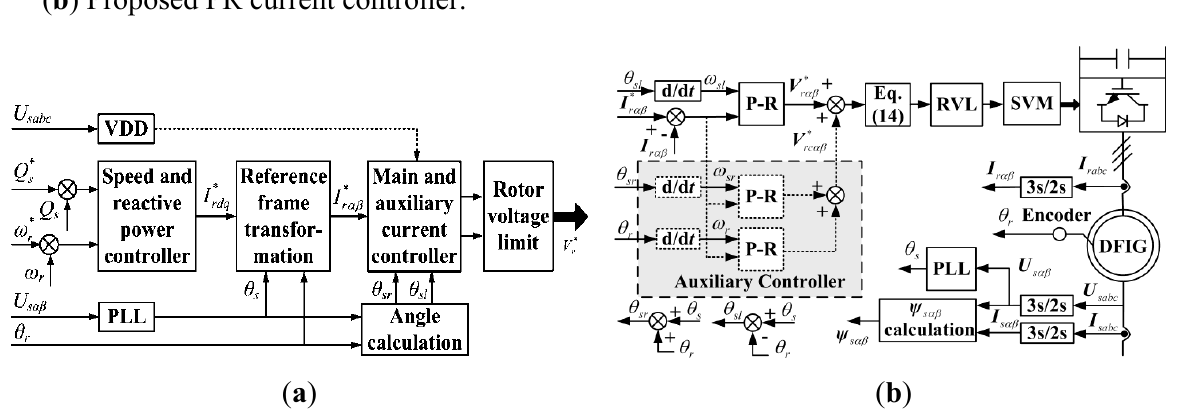
Figure 7. Schematic diagram of the proposed control system. ( a ) System control structure; ( b ) Proposed PR current